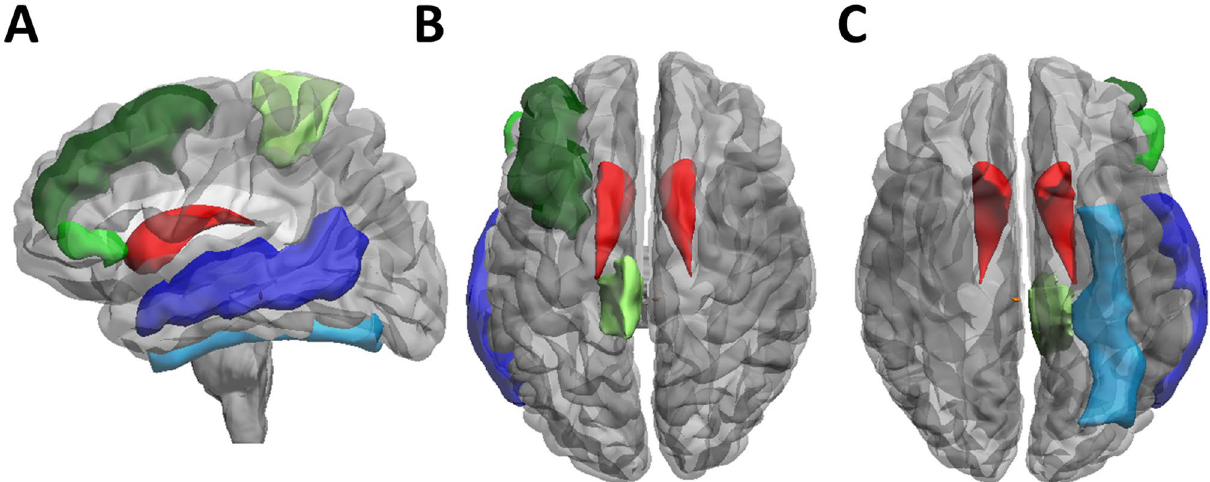
Figure 2. Anatomical localization of the significant volumetric changes in the ROI-based analysis shown in ( A ) left-lateral (i.e., ipsilesional), ( B ) dorsal and ( C ) ventral view. For the temporal cortex, a significant GM increase of the fusiform gyrus (light blue) and of the medial temporal gyrus (dark blue) in patients with sustained tinnitus after VS surgery. For the frontal cortex, there was an GM increase in the contralateral medial frontal gyrus (dark green) and the pars orbitalis of the inferior frontal gyrus (light green) as well as a significant GM decrease in the contralateral paracentral lobule (lime green). Finally, a significant GM increase of the ipsilateral superior colliculus (orange) in the bilateral caudate nucleus was detected